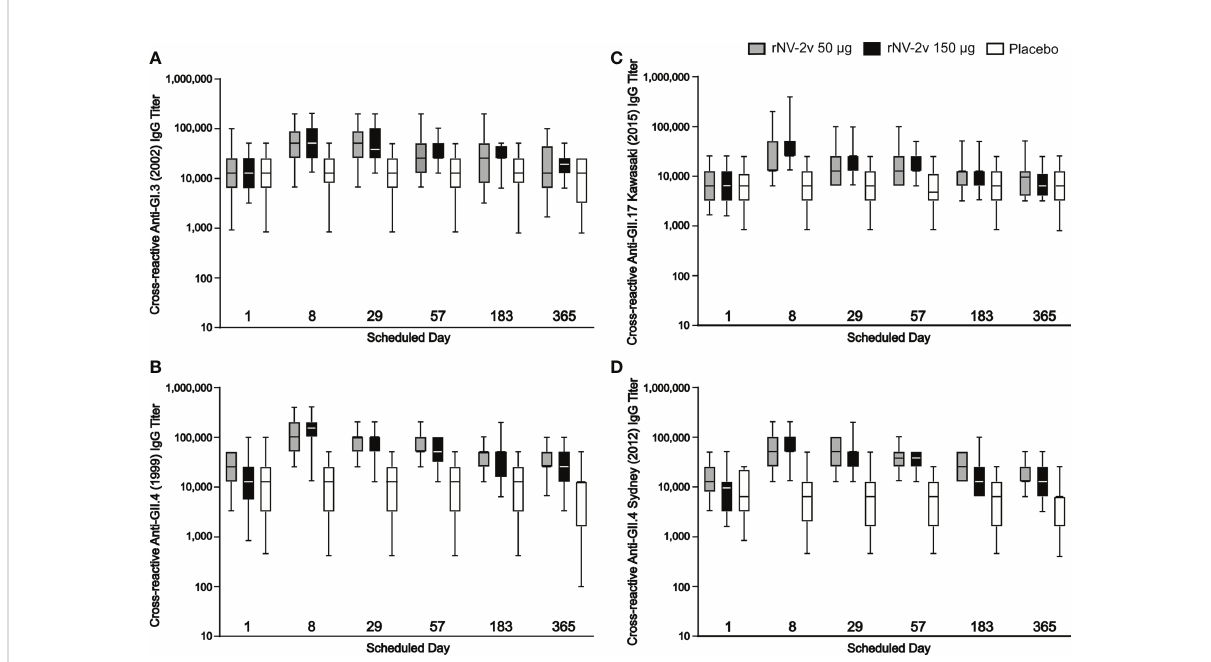
FIGURE 5 Humoral, cross-reactive anti-GI.3, anti-GII.4 and anti-GII.17 VLP IgG responses. Humoral, cross-reactive IgG responses against non-vaccine strain VLP scheduled time for each treatment. The cross-reactive IgG titer is de fi ned as the reciprocal of the highest serum dilution that gives a positive result. Anti-GI.3 (2002) (A) , anti-GII.4 (1999) (B) , anti-GII.17 Kawasaki 308 (2015) (C) and anti-GII.4 Sydney (2012) (D) VLP IgG responses for rNV-2v 50 µg (grey), 150 µg (black) and placebo (white) are shown as boxplots. The horizontal line represents the median, the bottom and top of the box represent 25 th and 75 th percentiles of the values, respectively, and the upper and lower error bar represent 5 th and 95 th percentile of the values, respectively. IgG, immunoglobulin G, VLP virus-like